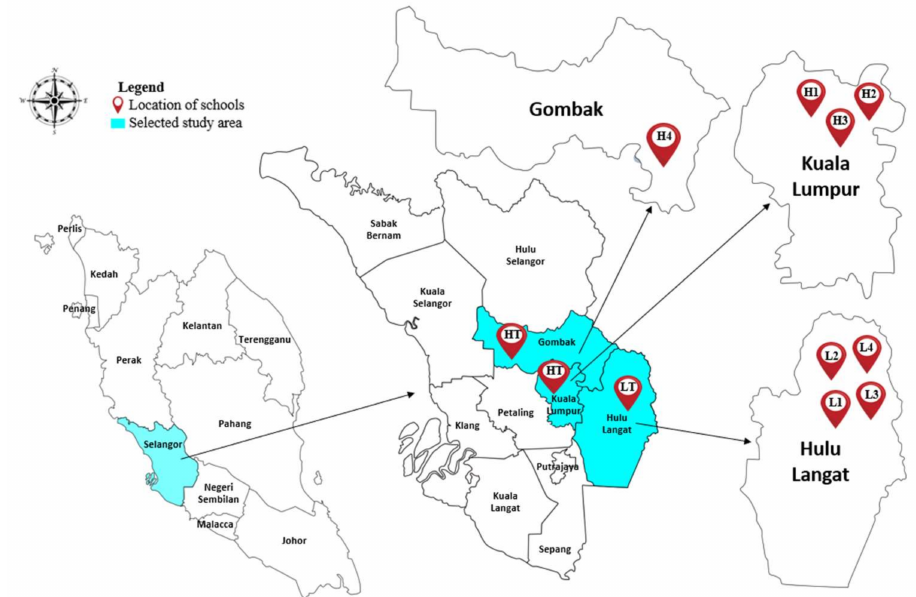
Figure 1. Locations of the selected primary schools. Primary schools in Kuala Lumpur and Gombak, were categorised as high traffic (HT) group with the schools in HT were designated H1, H2, H3 and H4. Primary schools in Hulu Langat, were categorised as the low traffic (LT) group, with the schools on LT designated as L1, L2, L3, and